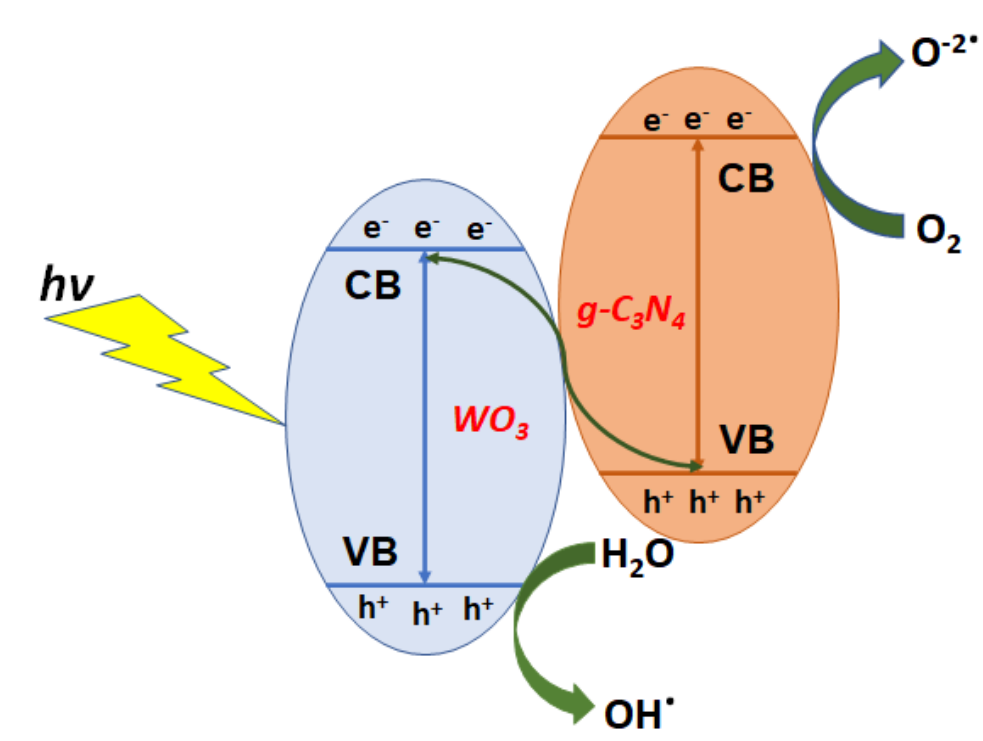
Figure 6. Photocatalytic mechanism of WO 3 /g-C 3 N 4 nanocomposites.